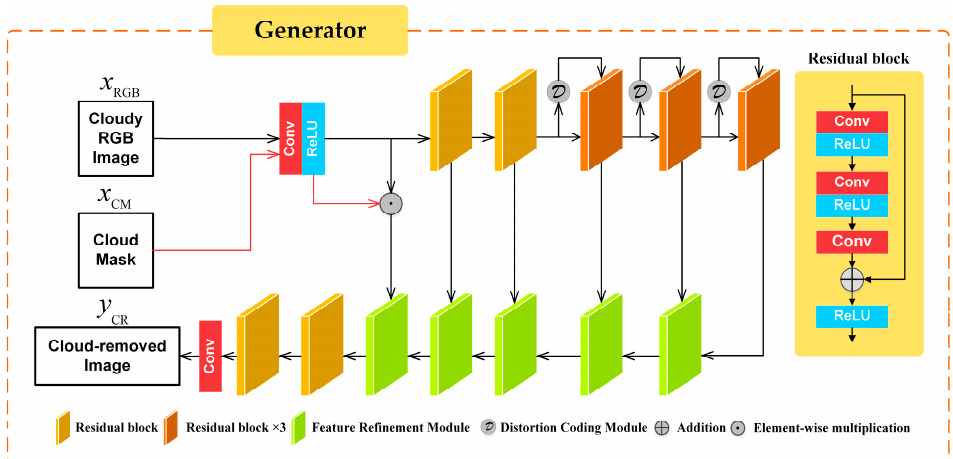
Figure 2. Architecture of the generator.